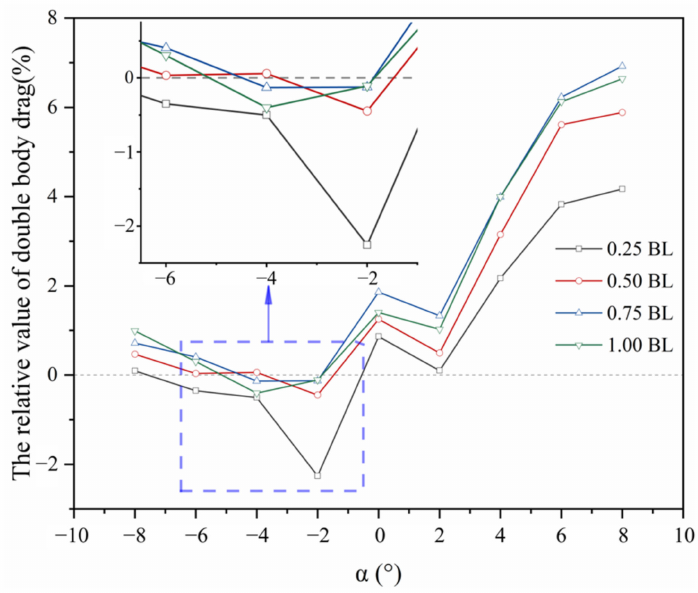
Figure 11. Relative value of the two manta rays gliding system average resistance